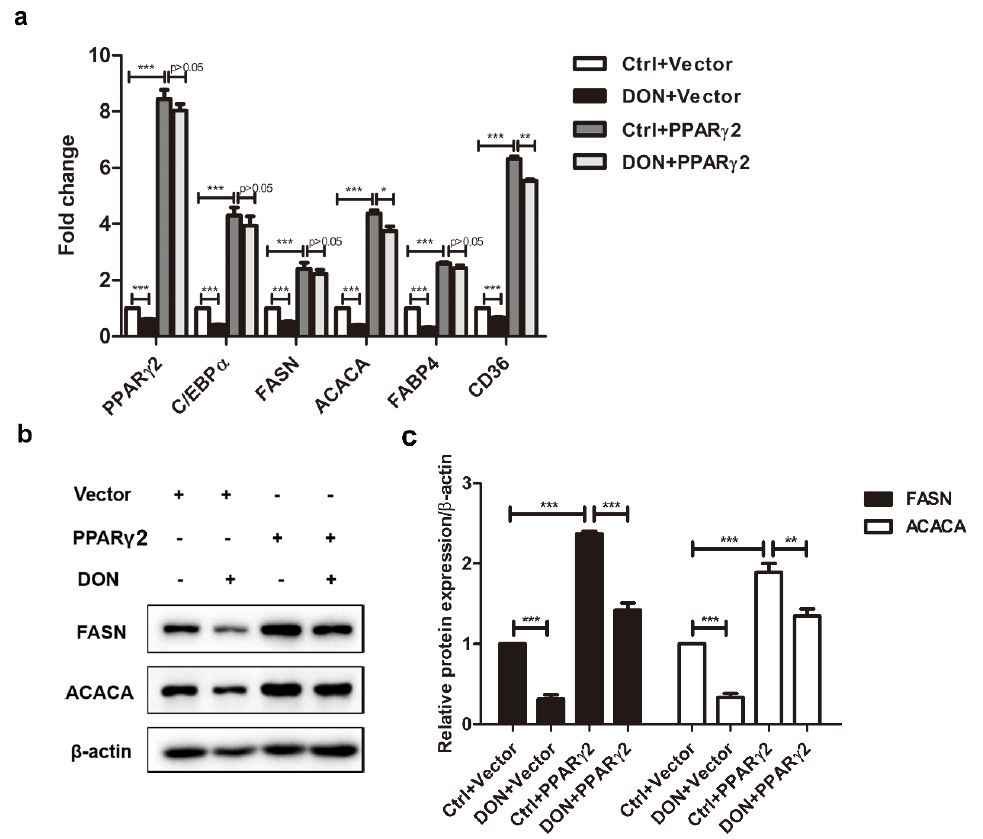
Figure 4. DON-induced downregulation of adipogenic marker genes was reversed by PPARγ2 overexpression in 3T3-L1 cells. Adipocyte cells were transfected with PPARγ2 or empty vector and treated with or without 100 ng/mL DON during differentiation. Total RNA or protein was isolated at the end of a 7-day differentiation. RT-PCR and Western blot analyses confirmed the expression of adipogenic marker genes. ( a ) C/ebpα , Pparγ2 , Fasn , Acaca , Fabp4 , and Cd36 mRNA levels in 3T3-L1 cells. ( b ) FASN and ACACA protein levels in 3T3-L1 cells. ( c ) Quantification of protein levels. The DON, PPARγ2 overexpression, and DON + PPARγ2 overexpression groups normalized by the control group. The results are representative of three independent experiments, and statistical significance is indicated by * p < 0.05, ** p < 0.01, *** p < 0.001.